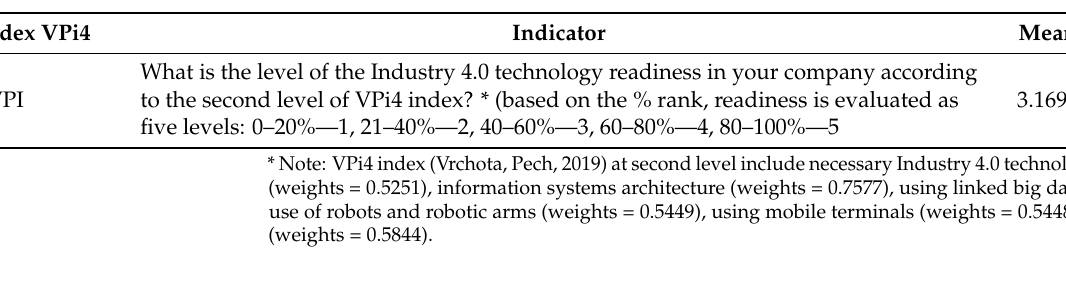
Table A3. The measurement items and indicators of